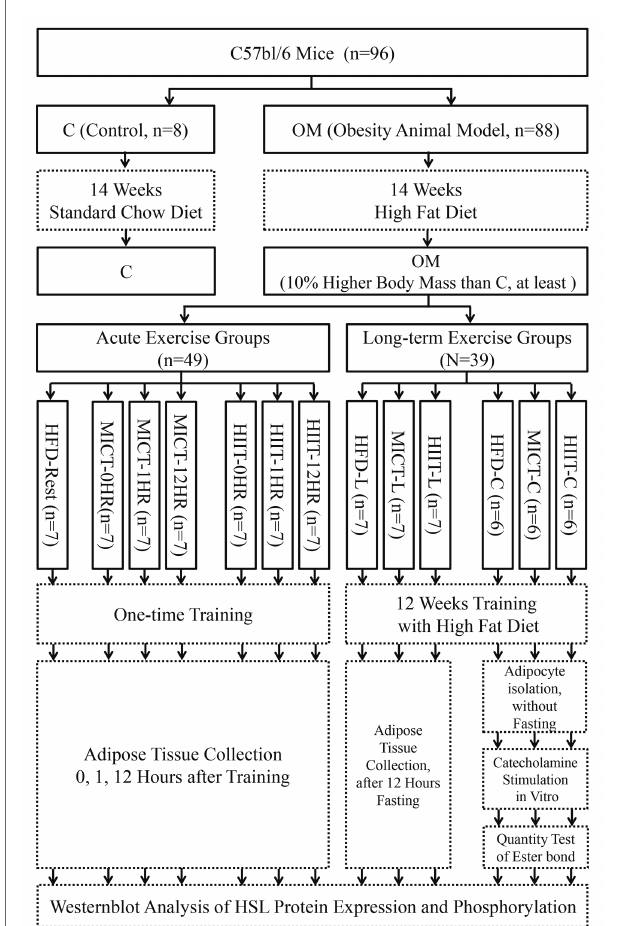
FIGURE 1 | Study design. Experimental groups are shown in solid boxes. Contents of intervention and test are shown in dotted boxes. The suffix “-nHR” means “n hours after acute exercise groups,” “-L” means “long-term training groups,” and “-C” means “primary adipocyte isolation groups after long-term